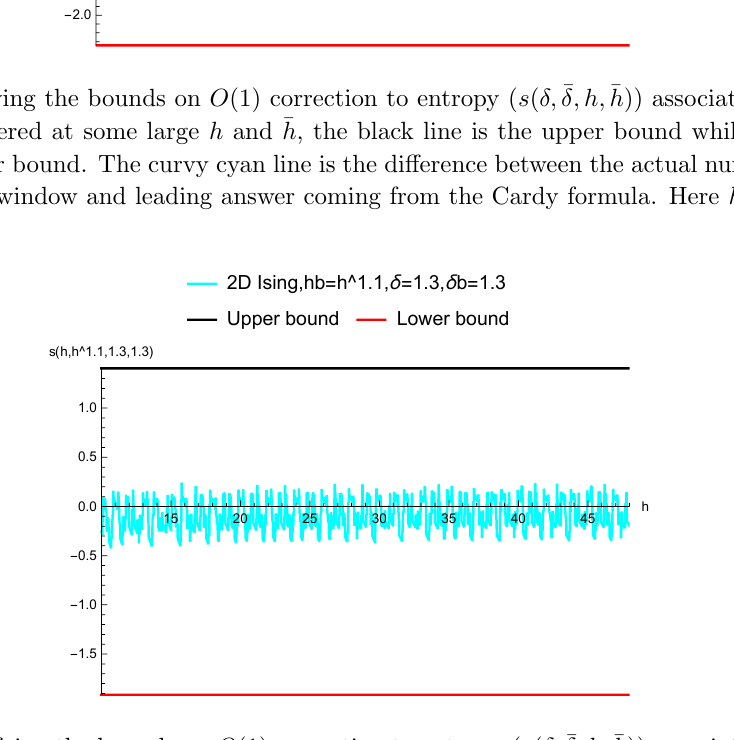
Figure 10 . Verifying the bounds on O (1) correction to entropy ( s ( (cid:14); (cid:22) (cid:14); h; (cid:22) h )) associated with order one window centered at some large h and (cid:22) h , the black line is the upper bound while the red line below is the lower bound. The curvy cyan line is the di(cid:11)erence between the actual number of states lying within the window and leading answer coming from the Cardy formula. Here h and (cid:22) h are not of the same